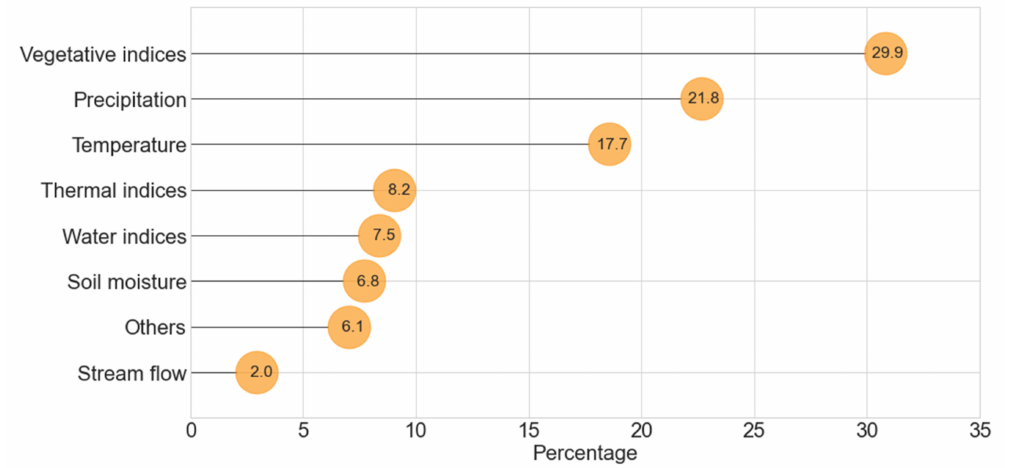
Figure 11. The input variables derived from remote sensing used for drought analysis. Vegetation indices were by far the most common extracted variable for assessing and monitoring droughts in Southeast Asia. The “others” indicate the remaining reported input variables, such as evapotranspi- ration, spectral bands, and burnt areas. Some studies employed multiple input variables.